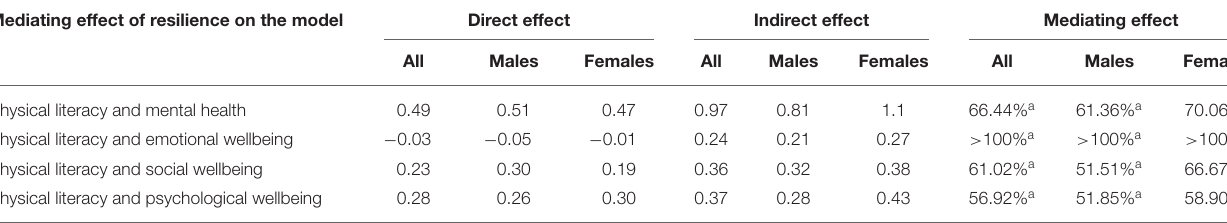
TABLE 2 | Mediating effect of resilience on the relationship among different variables. Mediating effect of resilience on the model